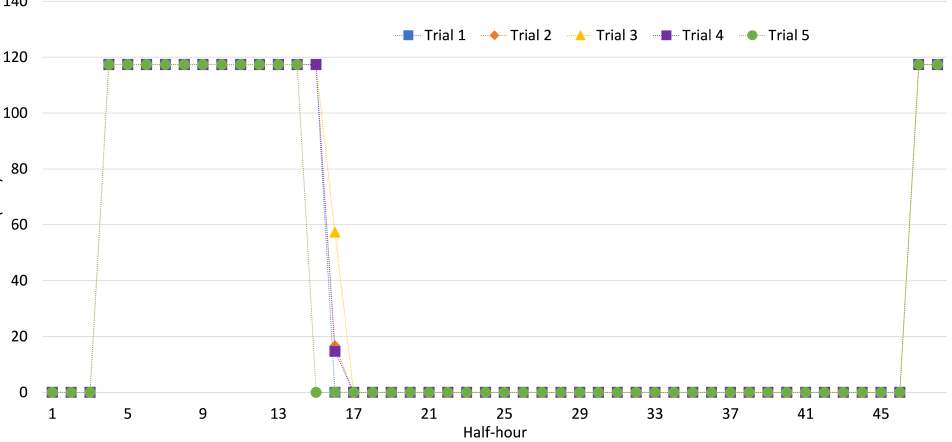
Figure 7. Violations of the operating zones of Salto Caxias in the 5 trials of Case